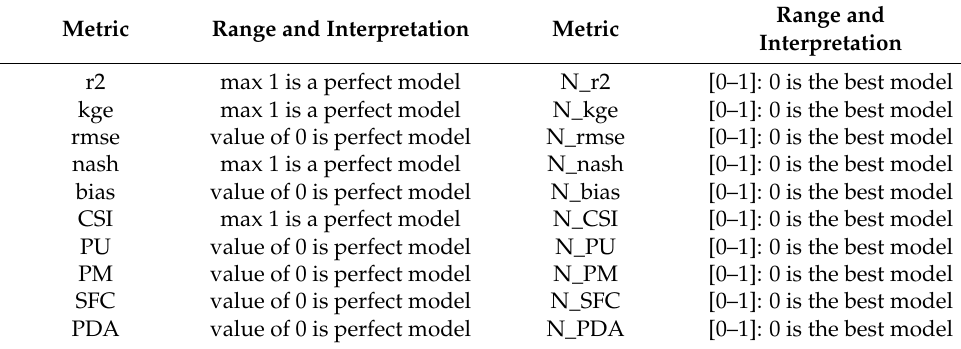
Table 5. Description of evaluation metrics and normalized counterparts.